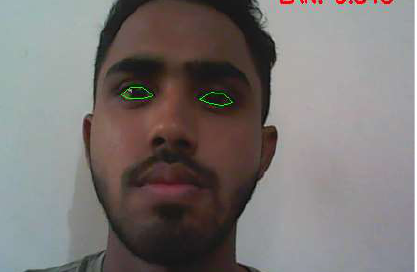
Figure 4: EAR=0.348